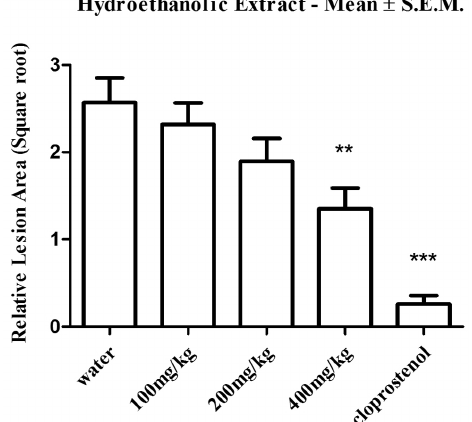
FIGURE 1 - Effect of the hydroethanolic extract from Kalanchoe pinnata leaves on the ethanol/HCl-induced gastric model in Wistar rats. Relative lesion area is presented as the mean ± S.E.M.; n=7 for each group. ANOVA was carried out and followed by